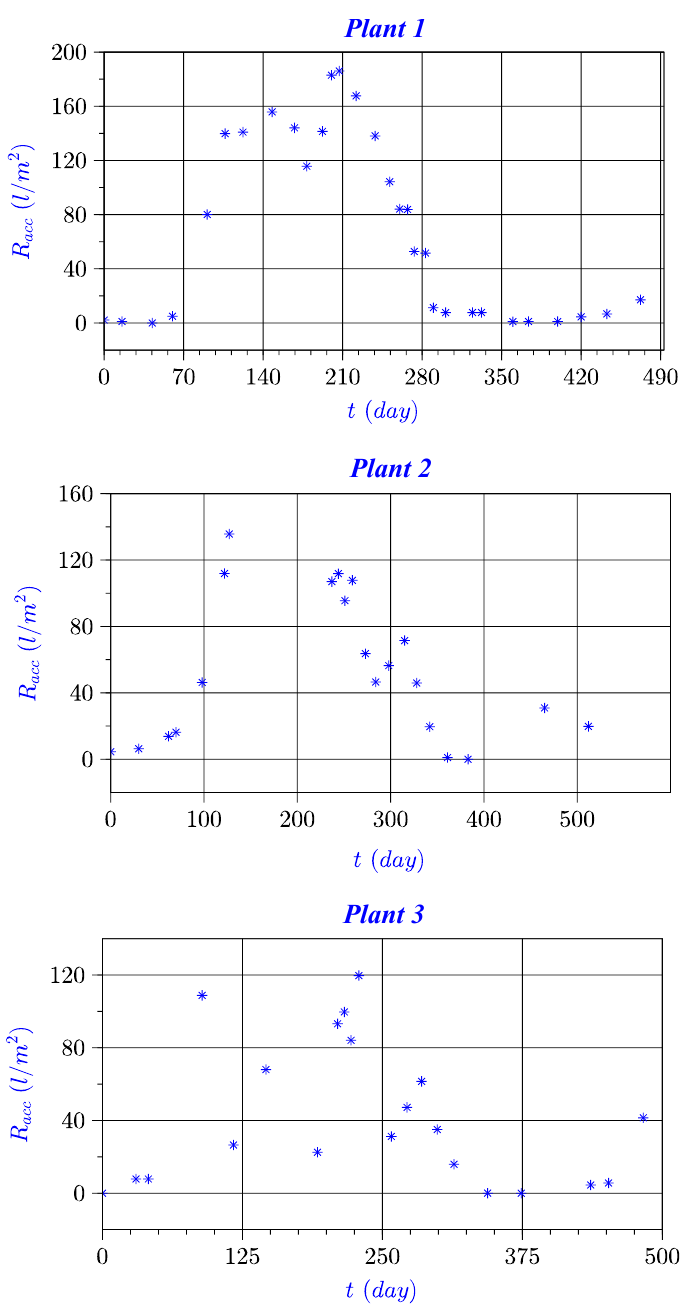
Figure A1. Rainfall results for plants 1, 2, and